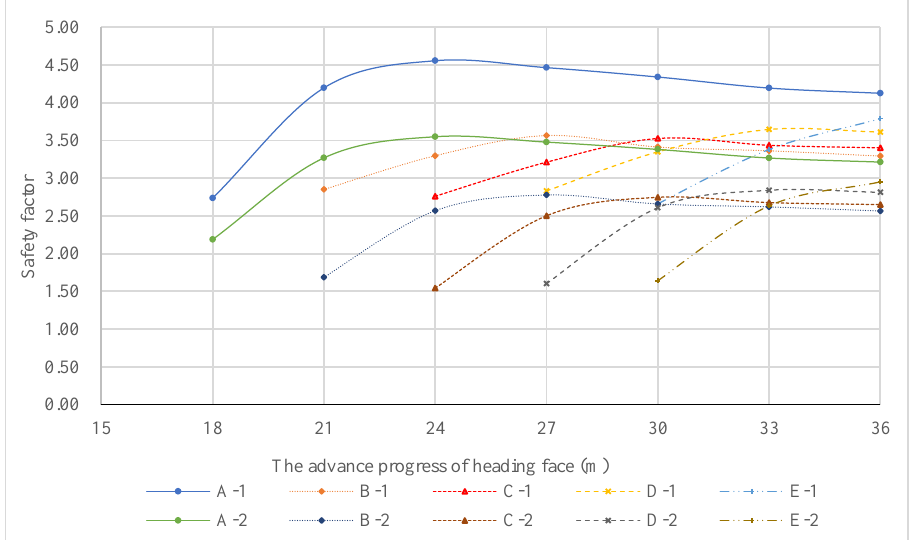
Figure 8. Safety factor trend of secondary lining arch crown.